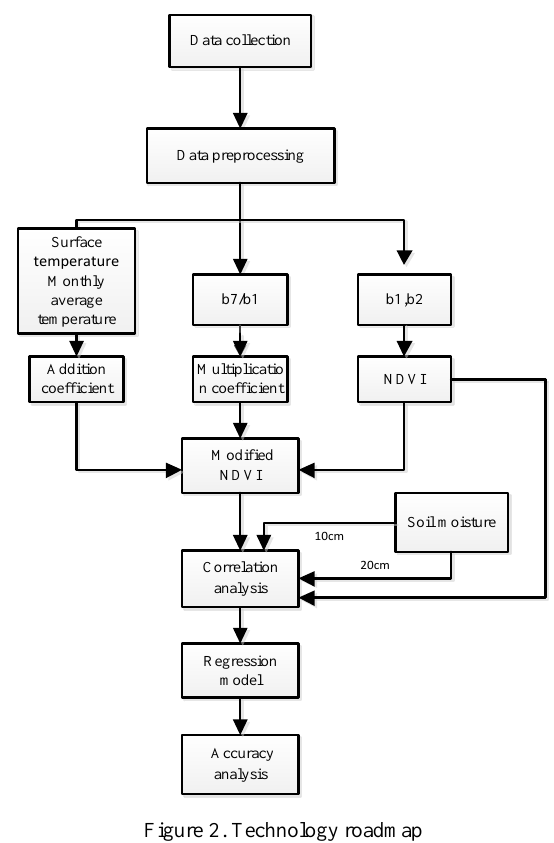
Figure 2. Technology roadmap